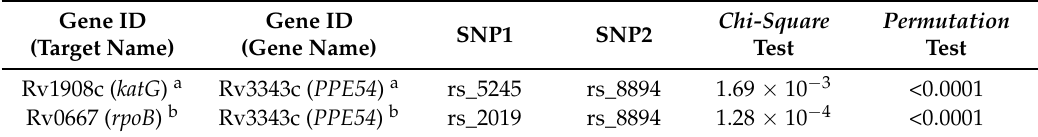
Table 3. The obtained gene pairs containing target genes in dataset 1.